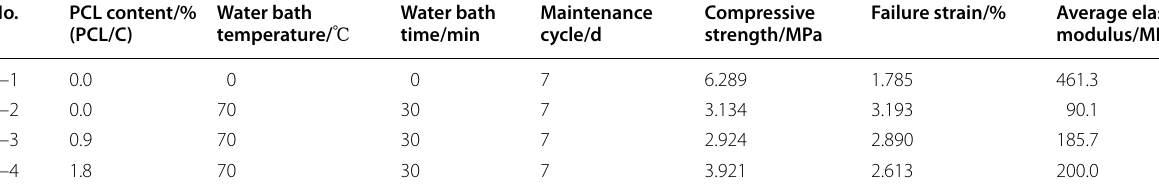
Table 5 Mechanical properties of cement paste with various PCL content.